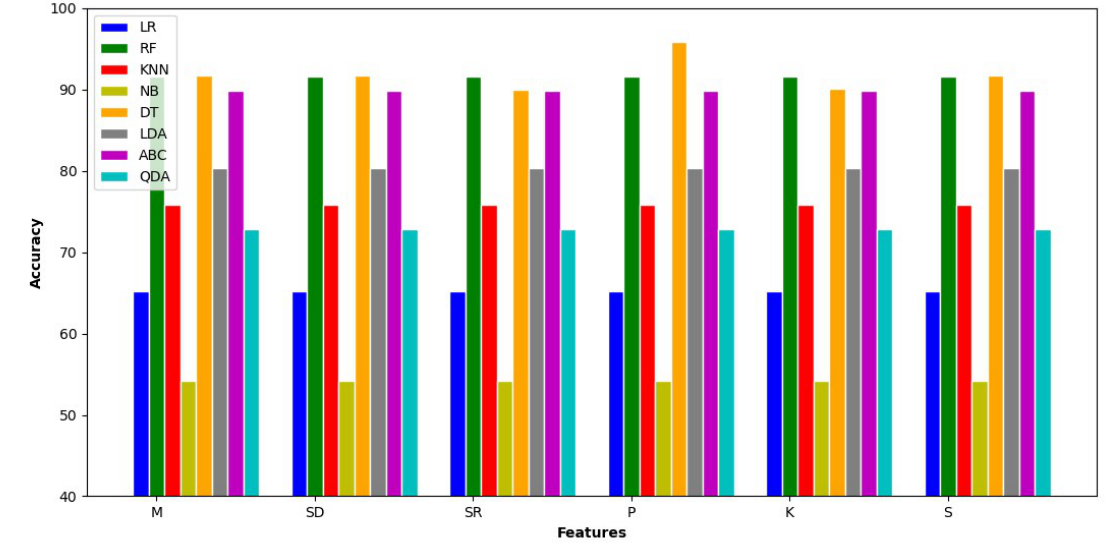
Figure 2. Experimental results for features.